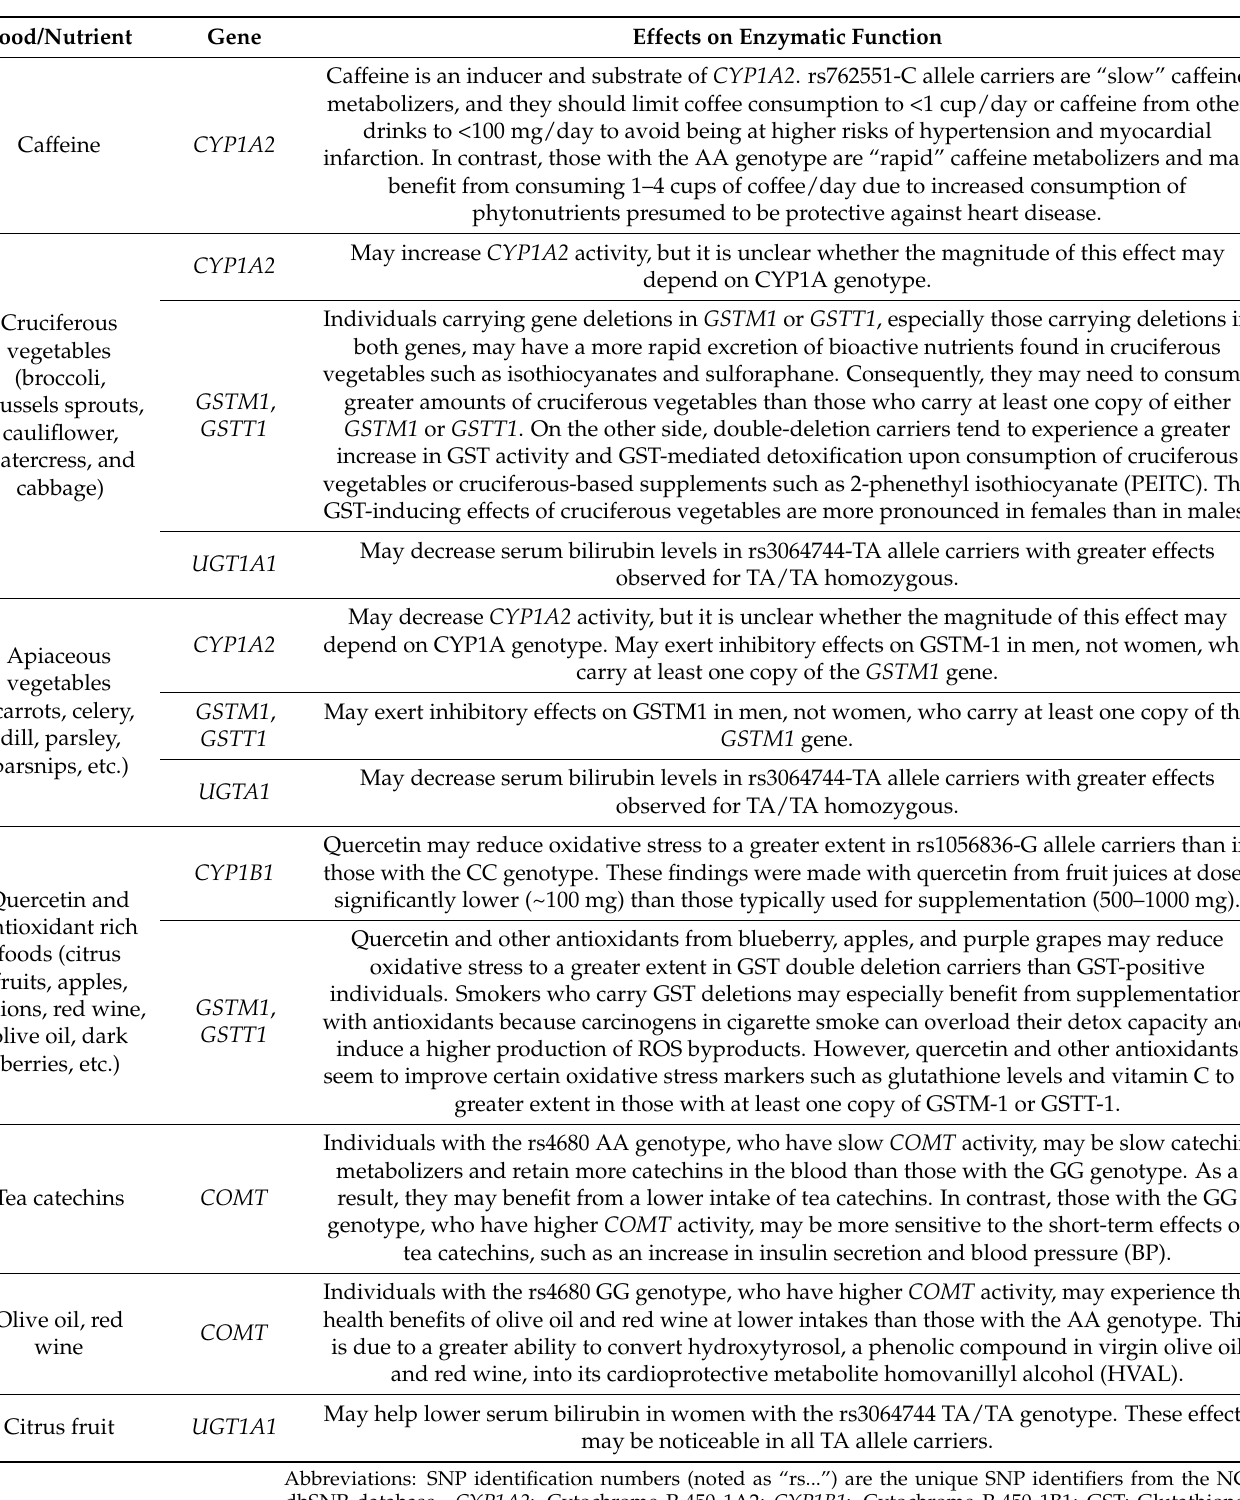
Table 2. Foods and nutrients that modulate the activity of Phase I/Phase II enzymes and their interaction with